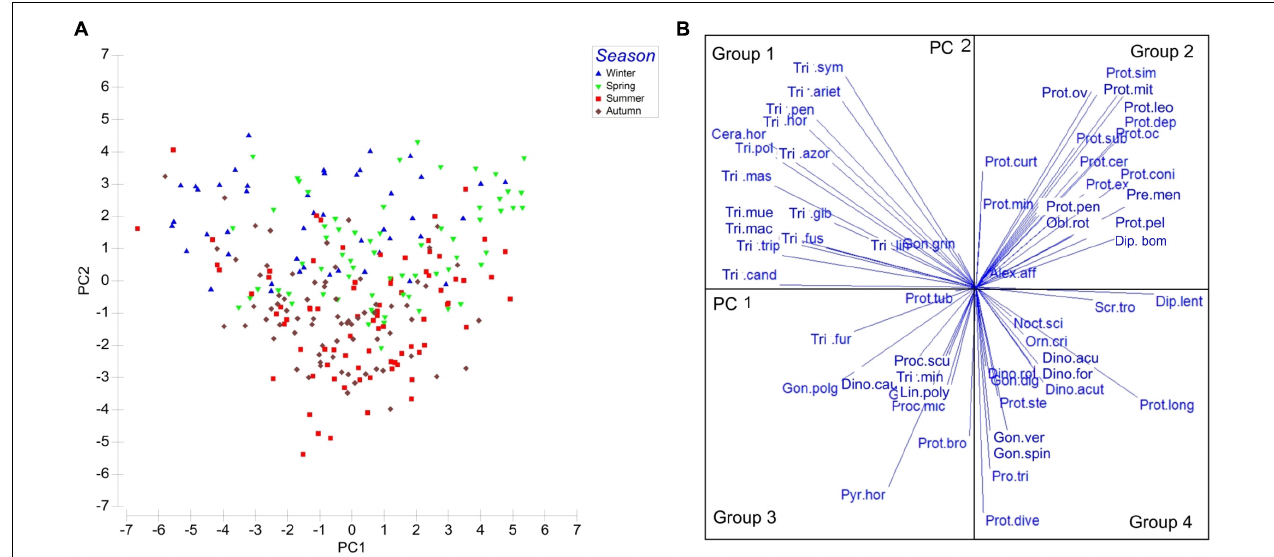
FIGURE 5 | PCA distribution of samples in the space defined by the principal components performed on normalized and standardized abundance of the 50 most abundant dinoflagellate species: (A) ; PC1 plus PC2 account for 16.2%, cumulatively with PC3 for 20.7% of variance: (B) Vectors of species variables.